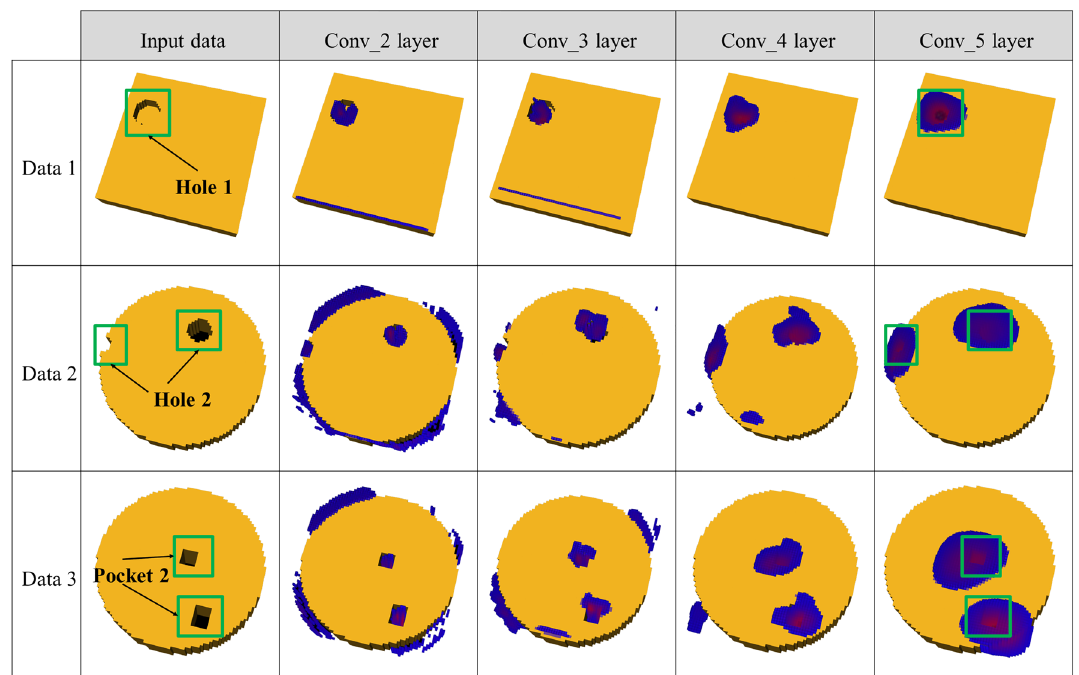
Figure 7. Visual explanation of the machining feature area using Grad-CAM for voxel size 64 × 64 ×